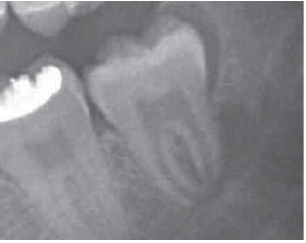
FIGURE 3. Pathology associated with semi-impacted man- dibular third molars: Radiograph of periodontal pocket at the distal aspect of mandibular third molar.